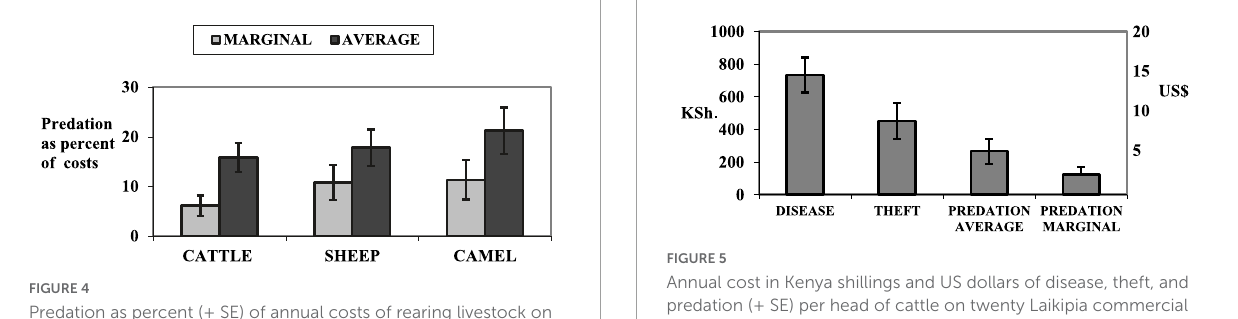
ranch in 1996. Given that lions are the primary draw for tourists